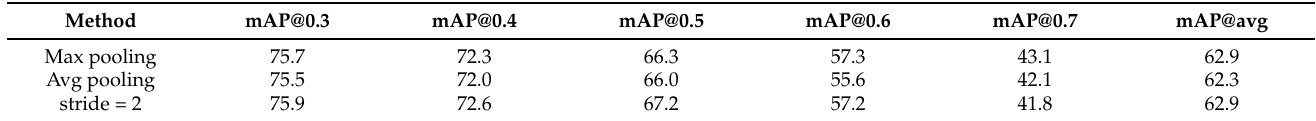
Table 9. Ablation study of different downsampling operations on THUMOS14 in terms of mAP(%)@tIoU.